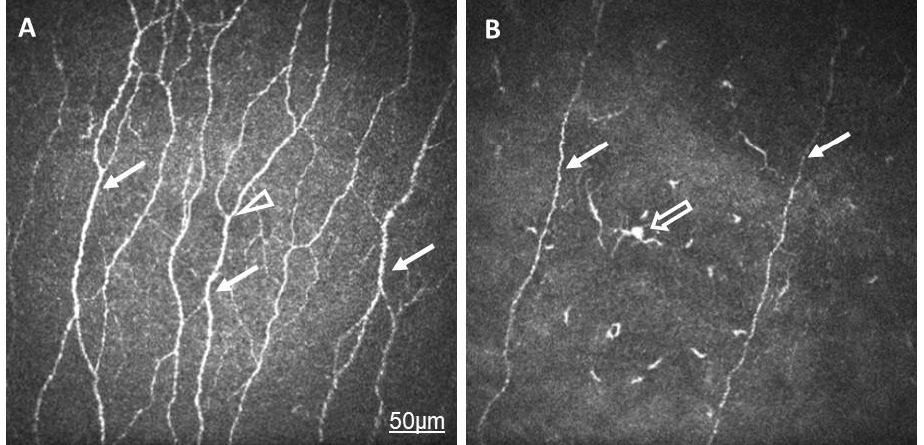
Figure 1. In vivo confocal microscopic images of corneal subepithelial nerves in a healthy eye ( A ) and in the eye of a patient with rheumatoid arthritis and dry eye ( B ). Note the lower density and reduced thickness of the subepithelial nerve plexi (arrow) in RA compared to in normal eyes. The number of branches (arrowhead) is minimal in RA. Langerhans cells with elongated dendrites are also demonstrated (empty arrow).